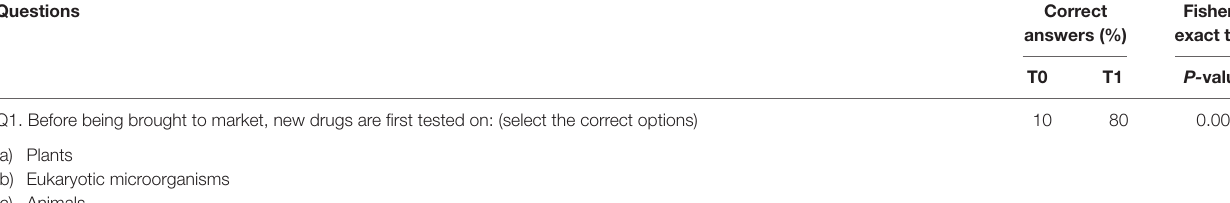
tAbLe 3 | Performance in the pre- (T0) and post-test (T1) for the control group.